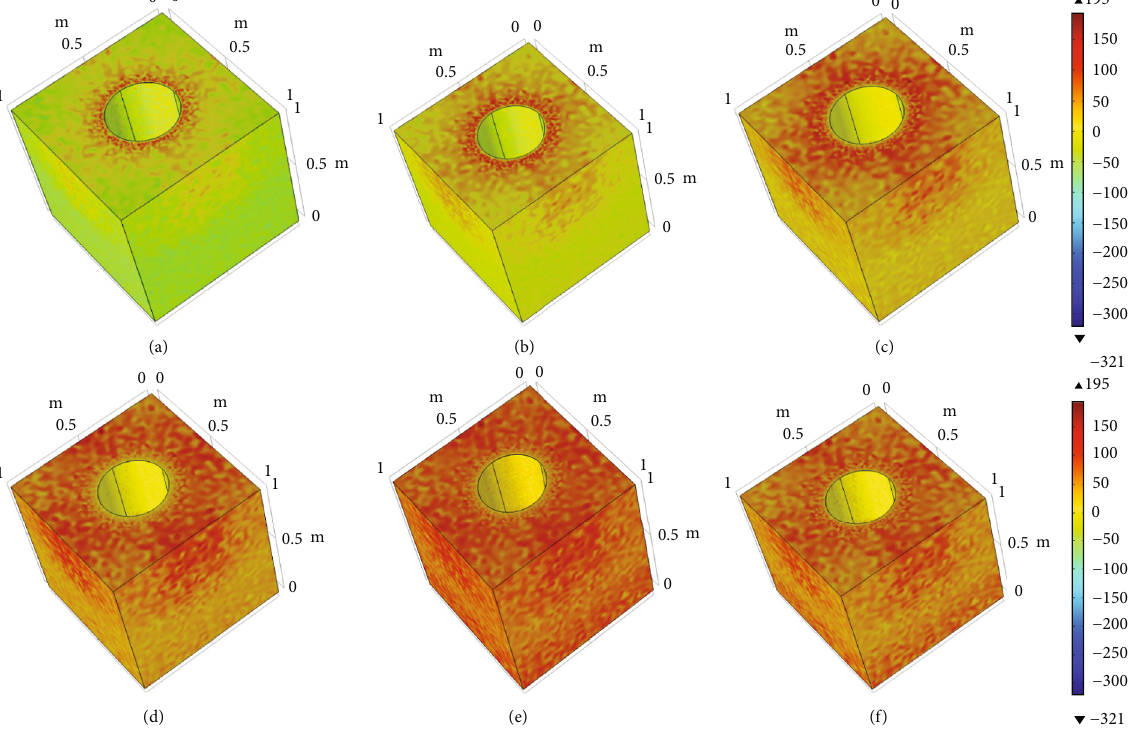
Figure 21: Stress fi eld in the m = 3 coal rock: (a) t = 0 : 1 s, (b) t = 1 × 10 3 s, (c) t = 1 × 10 4 s, (d) t = 1 × 10 5 s, (e) t = 1 × 10 6 s, and (f) t = 1 × 10 7